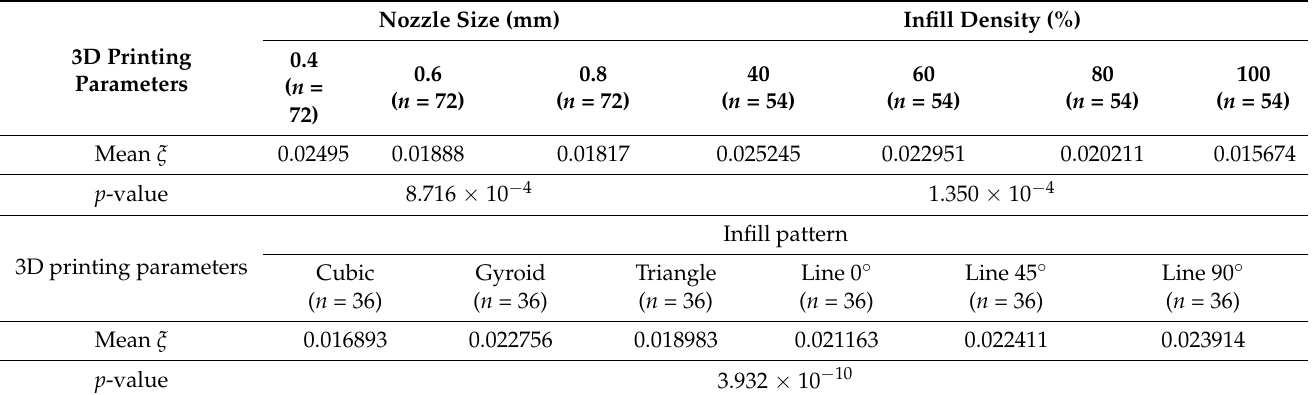
Table 2. ANOVA results ( n represents the sample size).